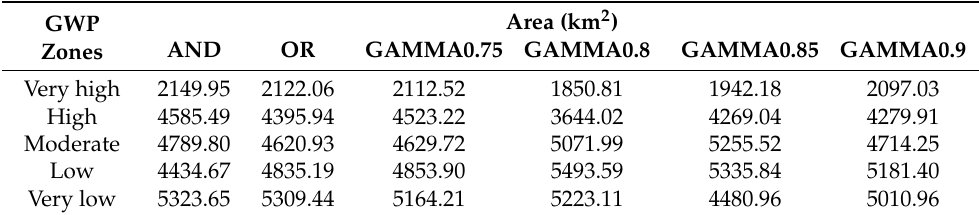
Table 1. Computation of area coverage under different GWP zones of hybrid